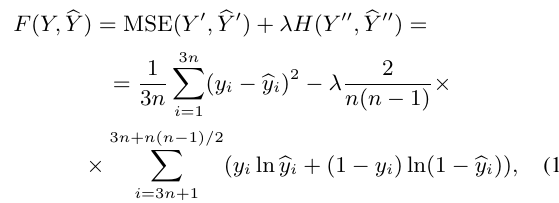
Figure 2. Node ordering (a) and length 11 neighbourhood construction for selected nodes (b,c,d). The color changes from red to blue according to the position in the list.